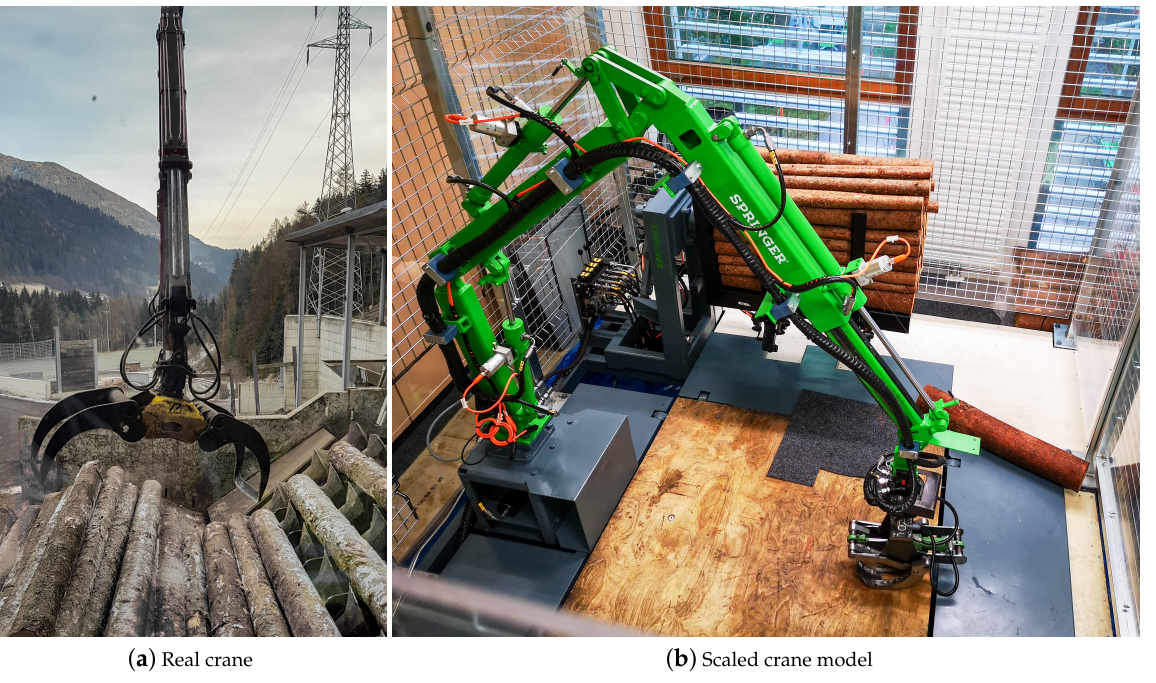
Figure 1. Hydraulic forestry crane for autonomous log manipulation. ( a ) Real crane, picture of a mobile forestry crane at a sawmill delivery and ( b ) scaled crane model, the 1:5 scaled model with hydraulics designed to match the scale and manual control equal to the real version. The scaled crane model has an arm length of 2.5m and it is surrounded by a protective cage, providing a workspace volume of approximately 20m 3